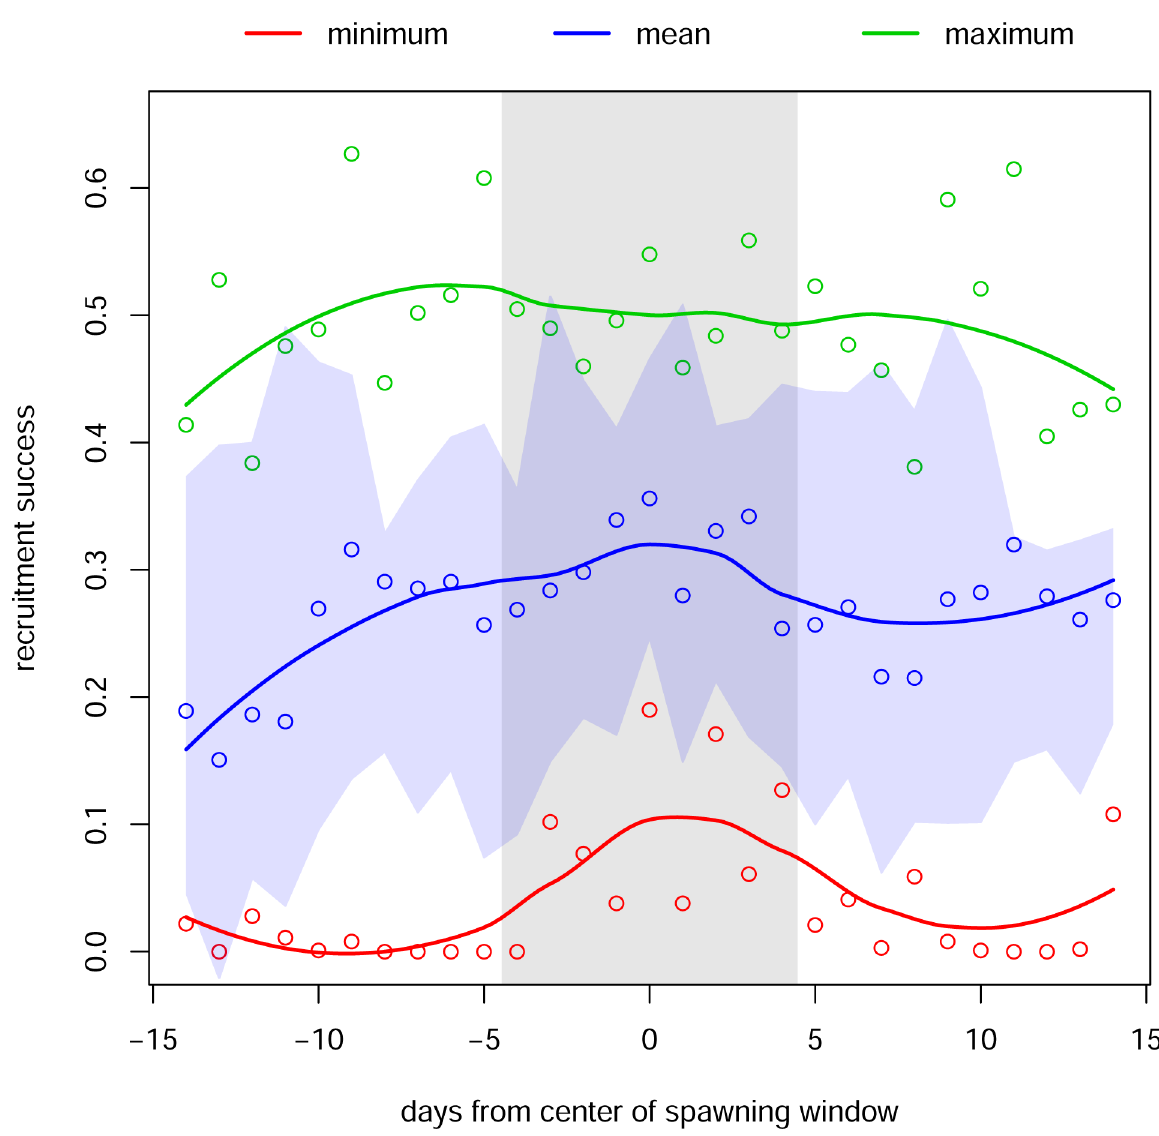
Fig 3. Maximum, mean, and minimum settlement success. Plotted values are calculated from 10 spawning periods (lunar months of May and June for 2003 – 2008). The vertical grey bar indicates the observed spawning period at Punta Hicacos. The horizontal blue swath portrays the variability in settlement success across the 10 spawning events (mean +/- 1